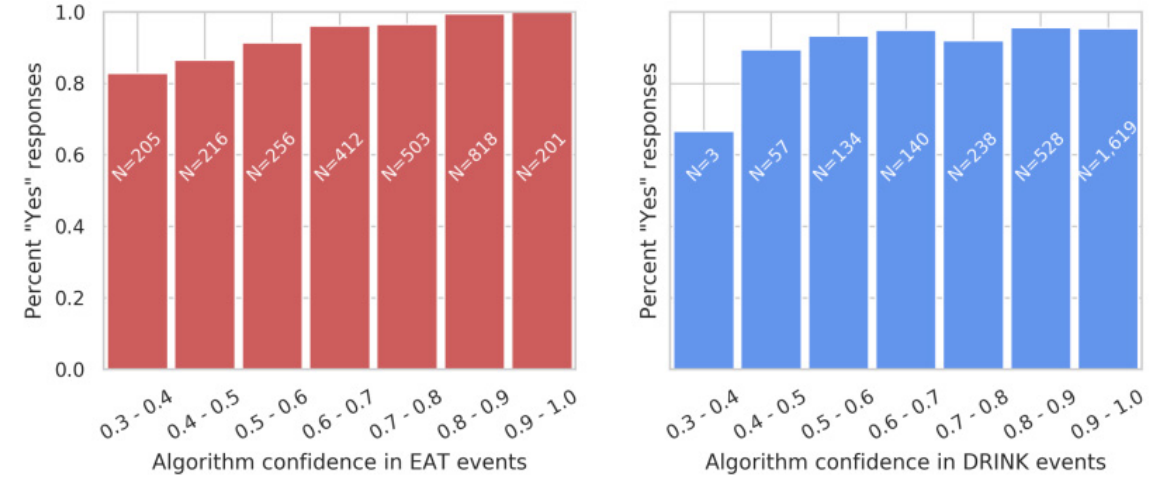
Figure 8. User responses to EAT and DRINK event validation requests. Responses to EAT events ( left ) and DRINK events ( right ) are grouped by the algorithm’s confidence in each event. Validation requests were sent automatically by email within 15 min of an event, and responses were allowed within 1 h of an event. Confidence estimates varied from 0.3 to 1.0 (events with lower confidence are dropped by the algorithm). Bars are annotated with the total number of responses in each bin.